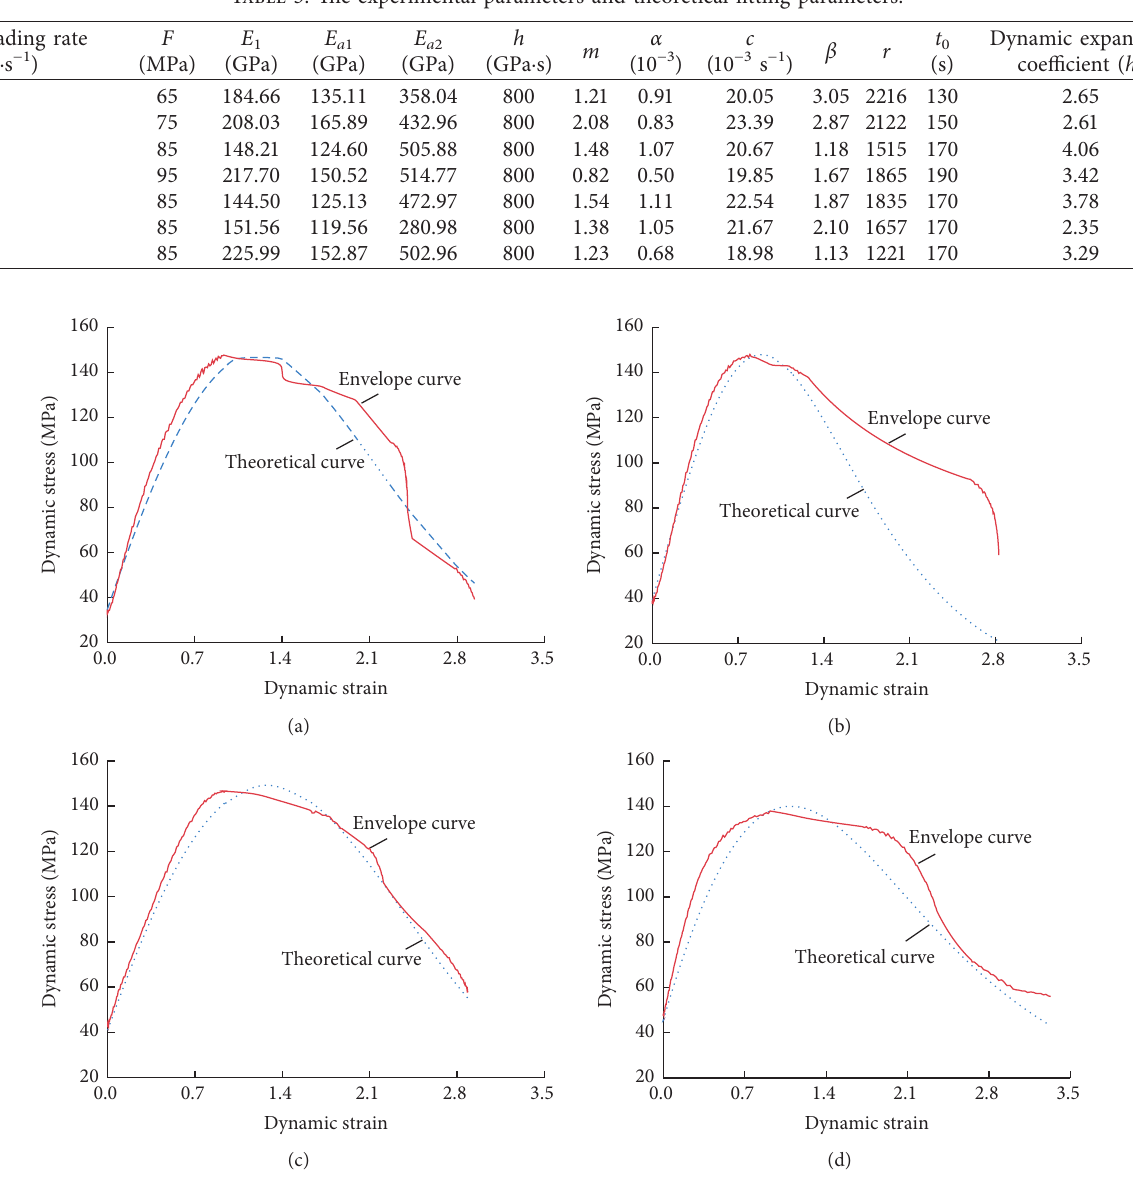
Figure 11: The comparison diagram of theoretical and experimental envelope curves of stress-strain under the axial unloading rate of 0.5MPa/s. (a) Preload axial pressure 65MPa. (b) Preload axial pressure 75MPa. (c) Preload axial pressure 85 MPa. (d) Preload axial pressure